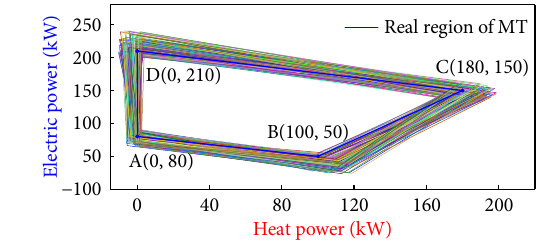
Fig. 3 Solutions of renewable energy characteristic identification.